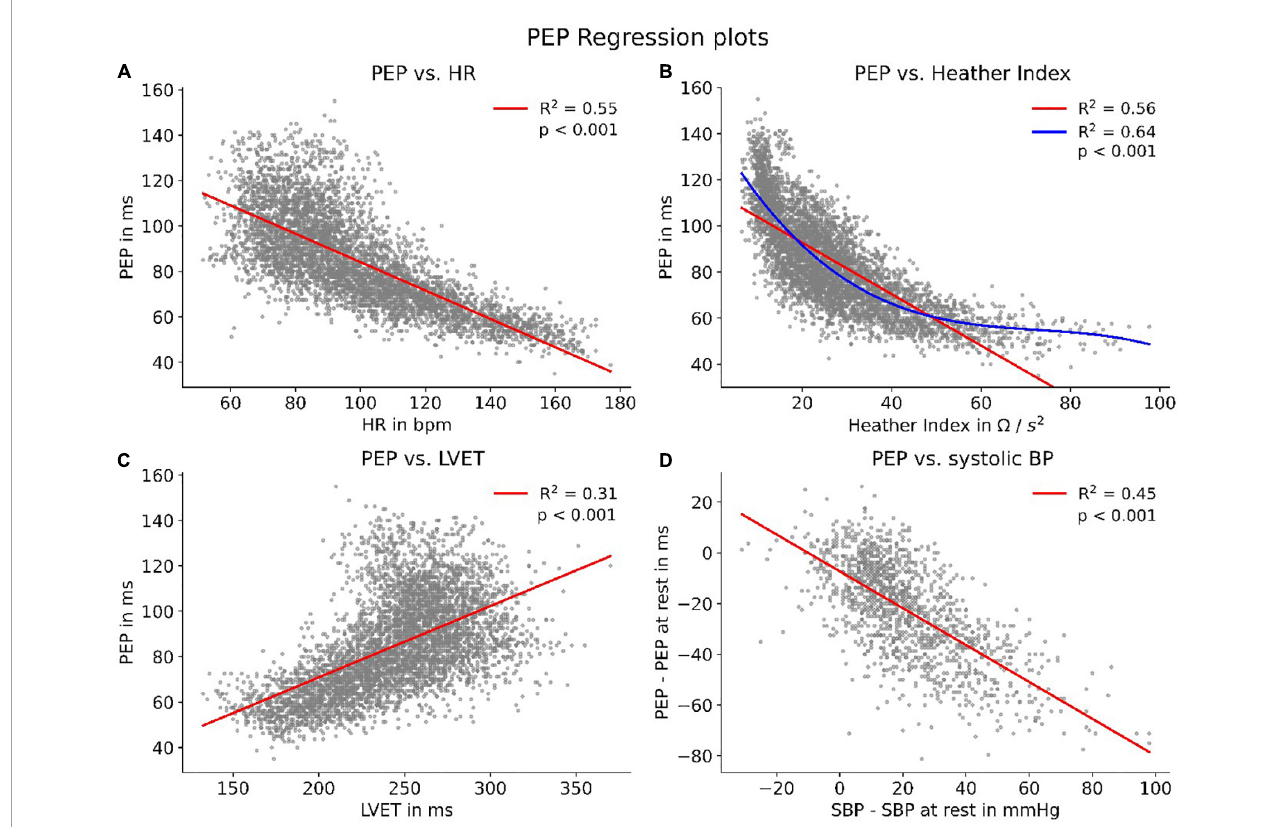
FIGURE5 HR, heart rate; LVET, left-ventricular-ejection-time; Correlations of PEP with parameters connected to sympathetic tone. To enhance visibility, panels (A–C) show scatters of 5,000 randomly sampled datapoints while correlation coefficients were calculated for the whole dataset. Panel (B) features an additional polynomial fit (blue) to account for the non-linear data distribution. Panel (D) shows the correlation between PEP and SBP compared to their respective values at rest.